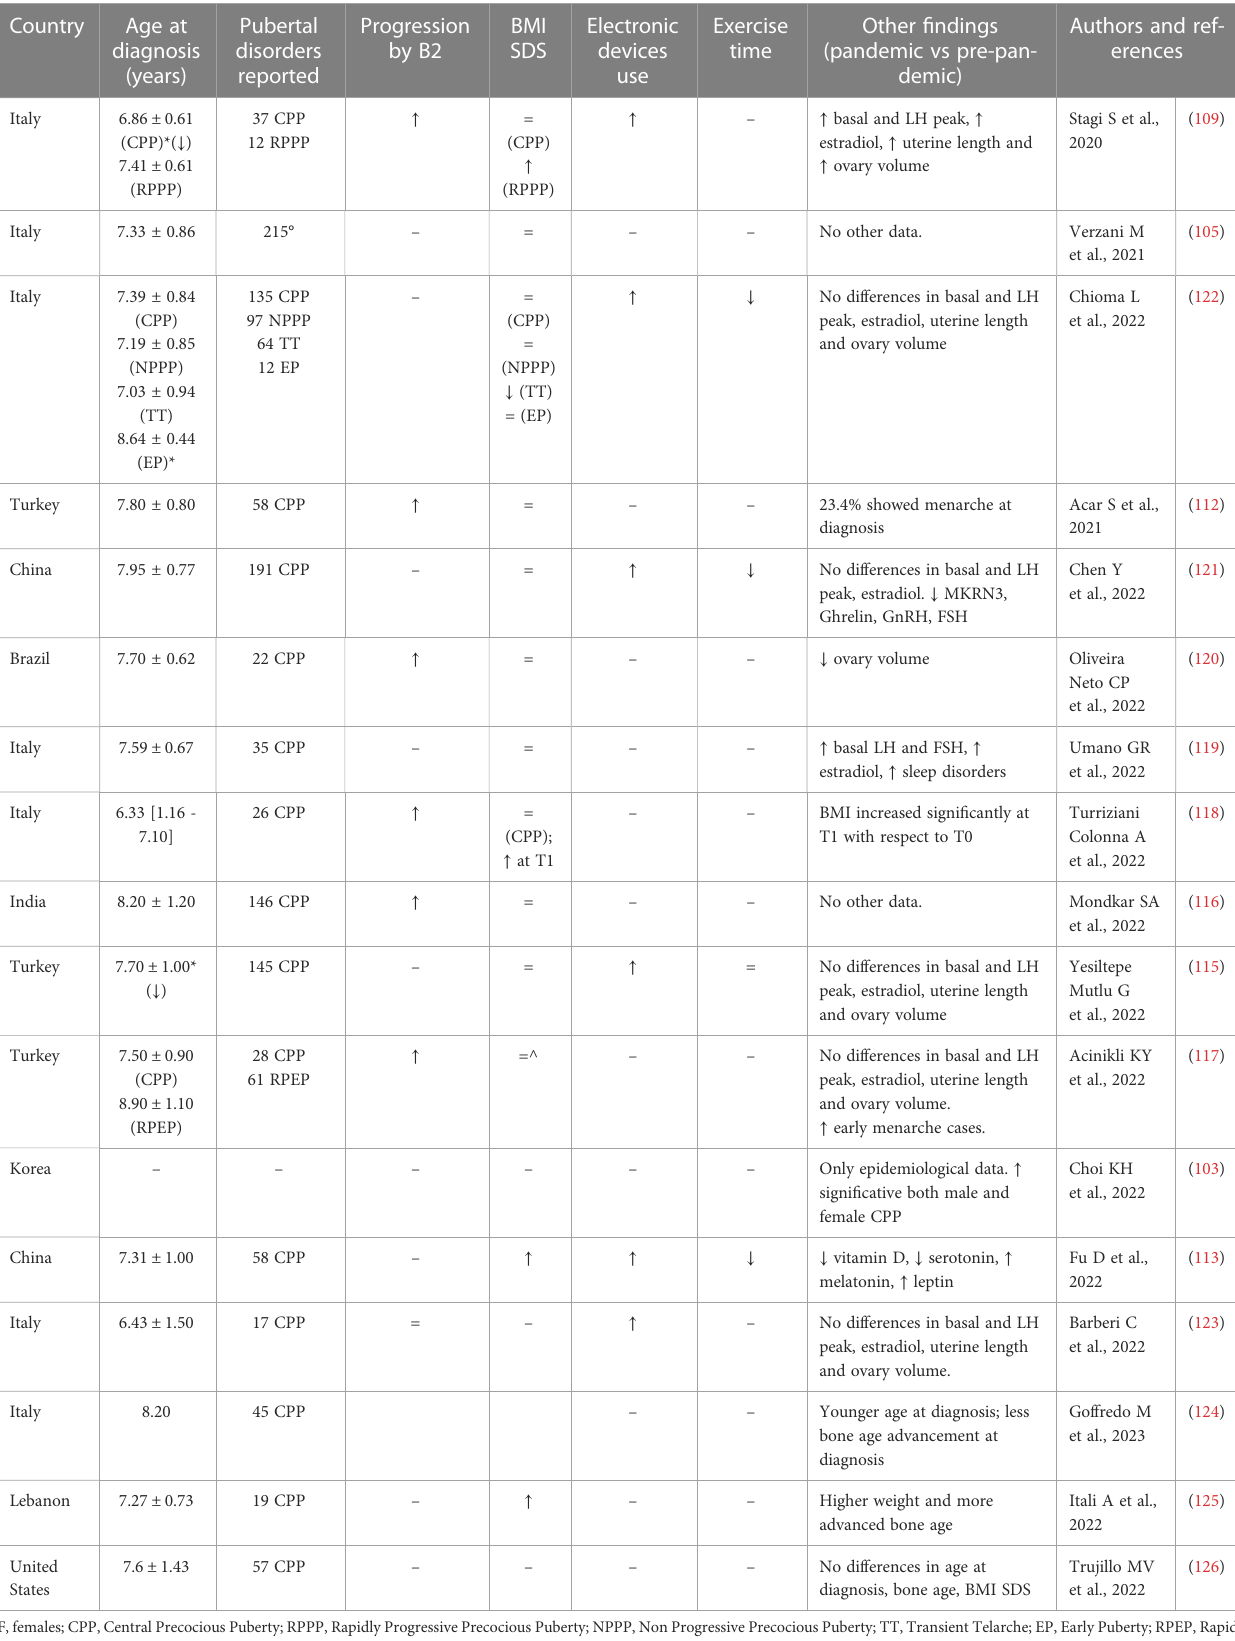
TABLE 1 Studies evaluating the disorders of puberty development in females during and after COVID-19